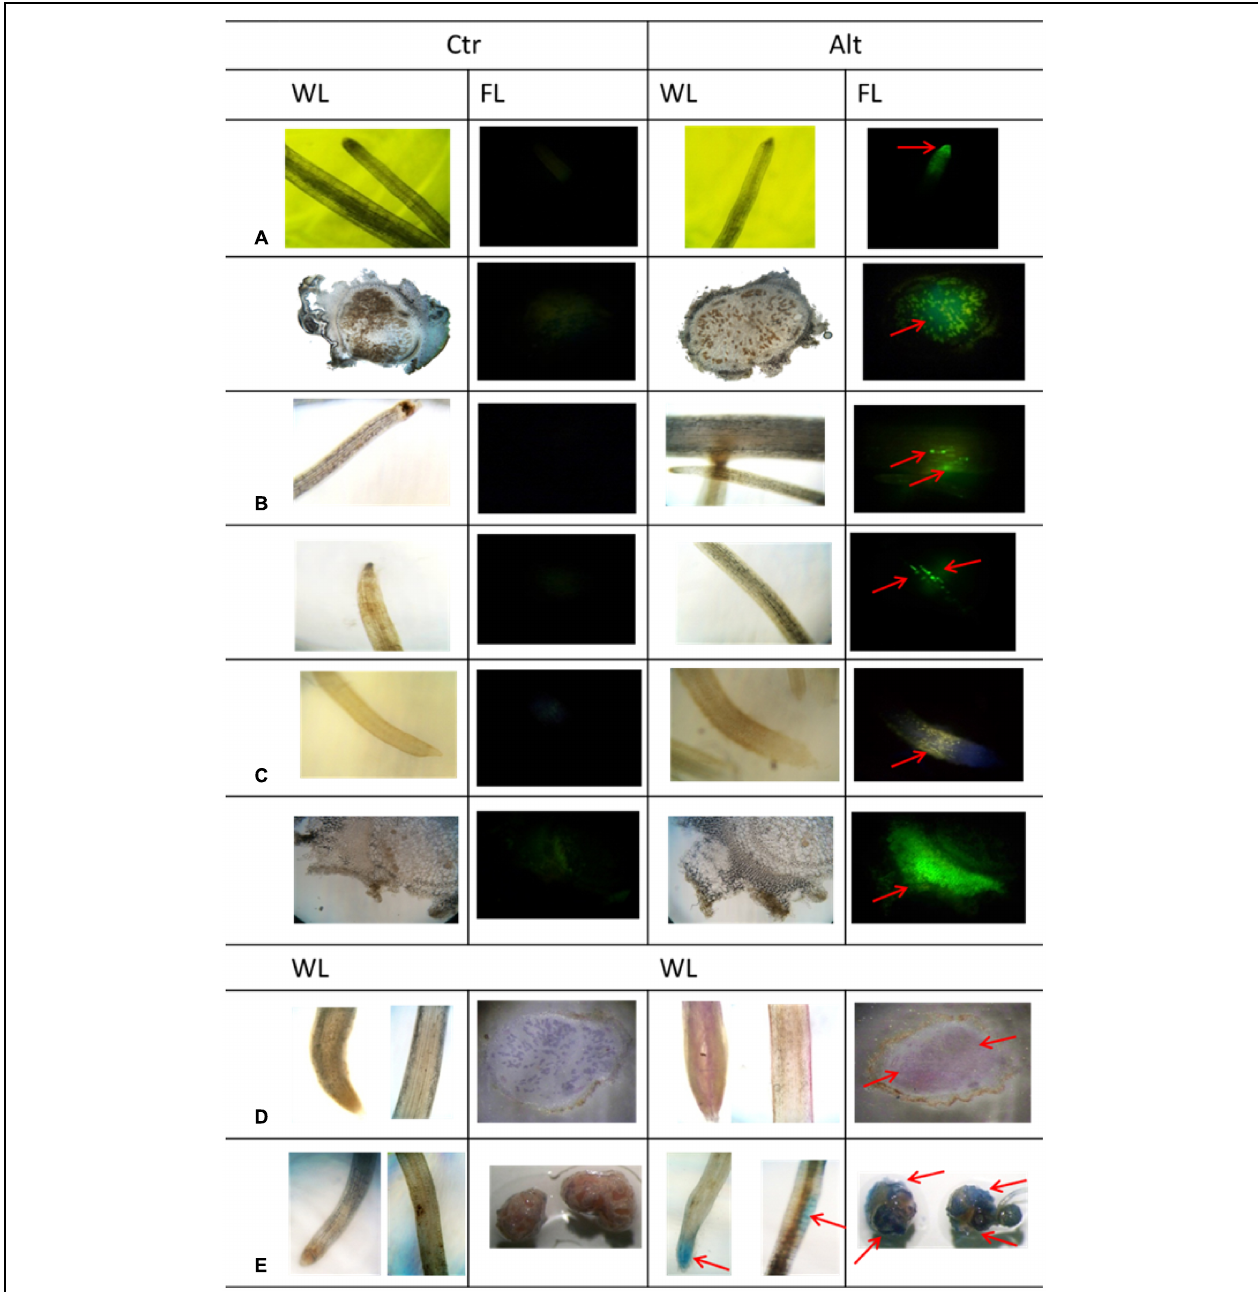
FIGURE 3 | Histological analysis of Al toxicity response in roots and mature nodules of R. tropici -inoculated common bean plants. SNF common bean plants were grown in control (Ctr) or in Al- toxicity (Alt) conditions. (A) Accumulation of Al evidenced by Al-morin fluorescence. Magnification = 10X, for roots and nodules (B) ROS (H 2 O 2 ) production detected by DCF-DA fluorescence. Magnification = 10X (C) Callose distribution evidenced by fluorescence emitted after aniline blue staining.